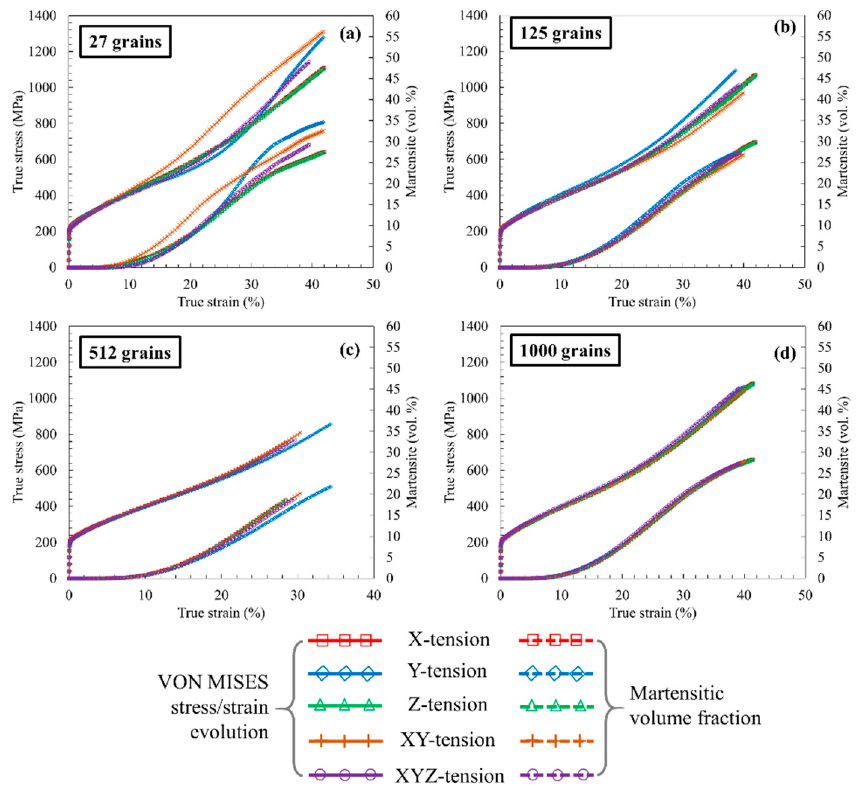
Figure 12. Comparison of the stress/strain and transformation curves for the simulation models with: ( a ) 27 grains; ( b ) 125 grains; ( c ) 512 grains; and ( d ) 1000 grains (reprinted with permission from [44], Carl Hanser Verlag, 2020).